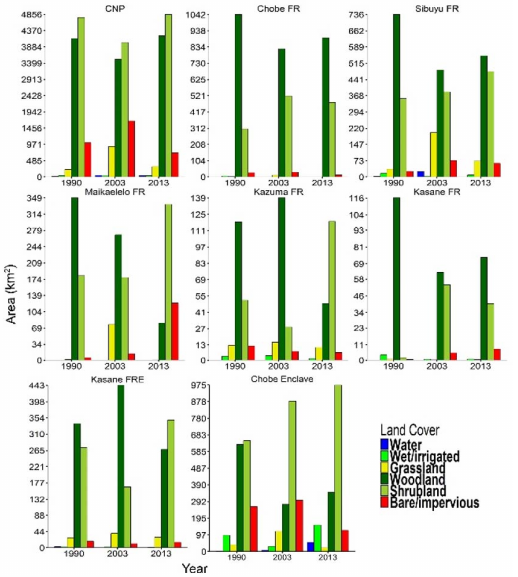
Figure 7. Land cover (km 2 ) in the Chobe National Park and six protected forest reserves, the Chobe Enclave for 1990, 2003, and